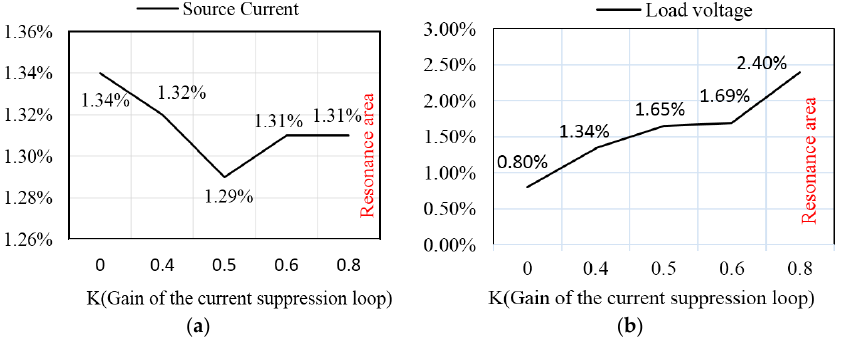
Figure 16. The THD (in percent) when the proposed SRF method equipped with the improved SF is